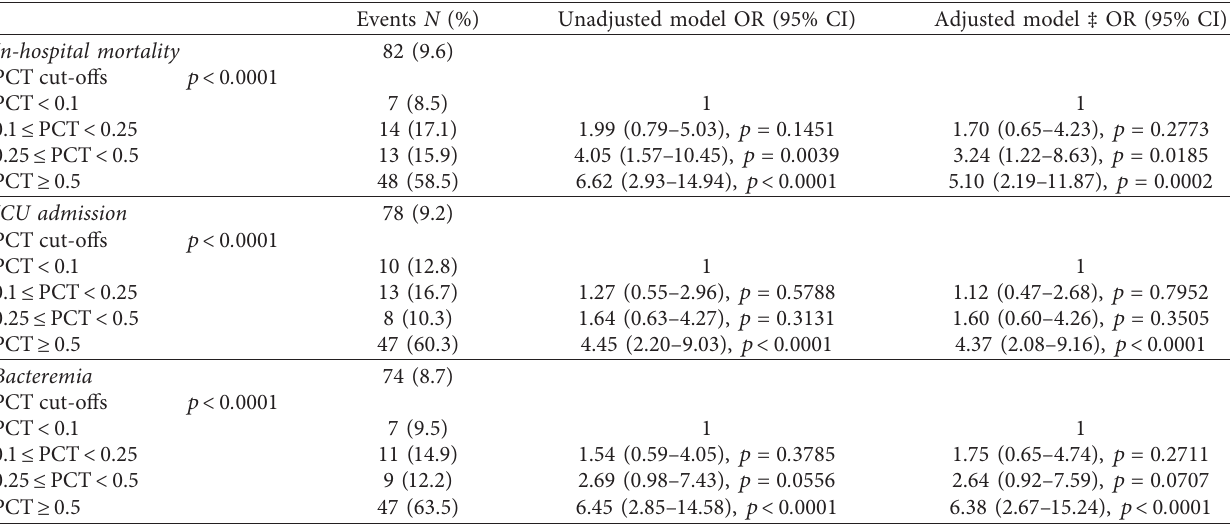
Table 2: Association of initial procalcitonin levels and clinical outcomes in univariate and multivariate logistic regression